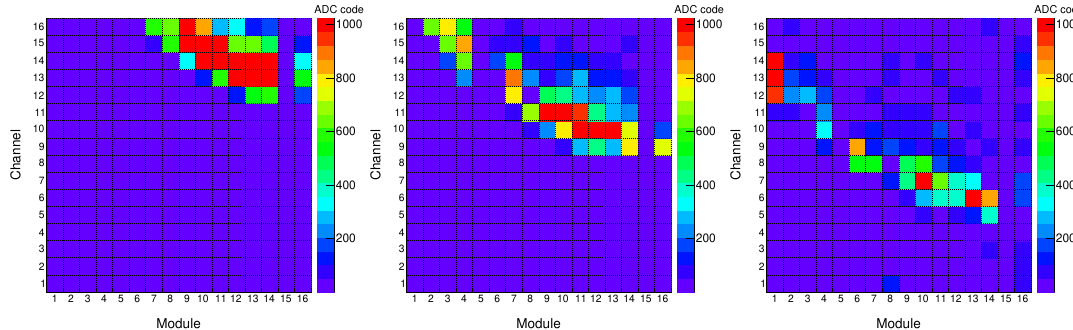
Figure 2. Snapshots of the focal plane show the arc-like shape and movement of an image of the elve registered on 23 August 2017, through the detector’s field of view. The snapshots were taken at 136 µ s, 168 µ s and 200 µ s from the beginning of the record. Colors denote the signal amplitude in ADC codes.